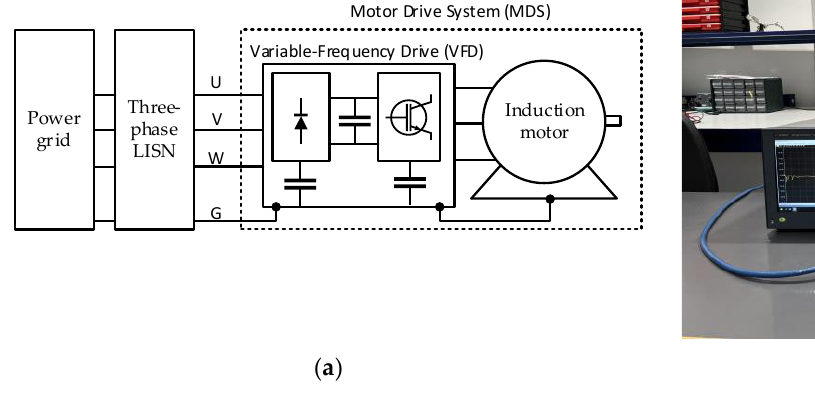
Figure 6. ( a ) Diagram of the motor drive system, and ( b ) a picture of the single-probe setup used to measure the motor drive system impedances. Table 3. Specifications of motor drive system and instruments.